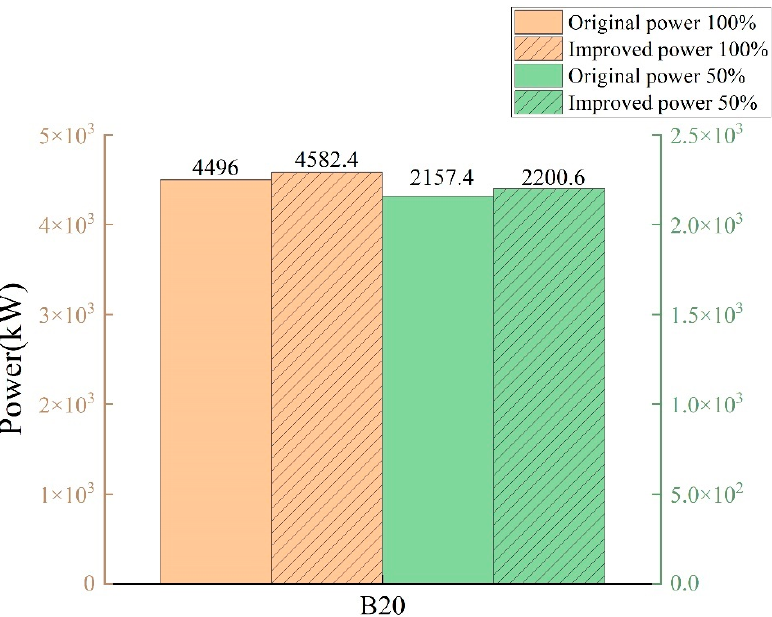
Figure 11. Comparison between the improved power and the original value under 100% and 50% load.